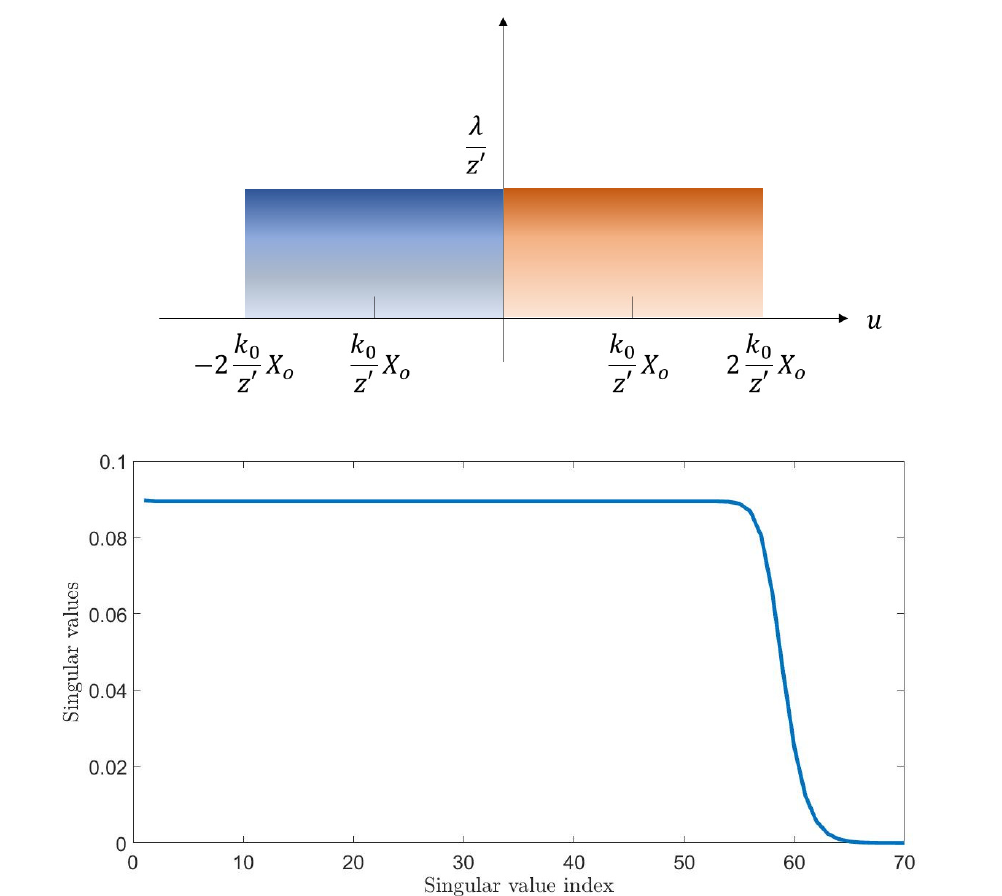
Figure 2. Case of two views S i = {− X o , X o } . The top panel shows the two frequency bands, while in the bottom panel the singular values of the relative scattering operator are plotted. For the simulation, the configuration parameters are a = 30 λ , X o = 30 λ and z (cid:48) = 125 λ